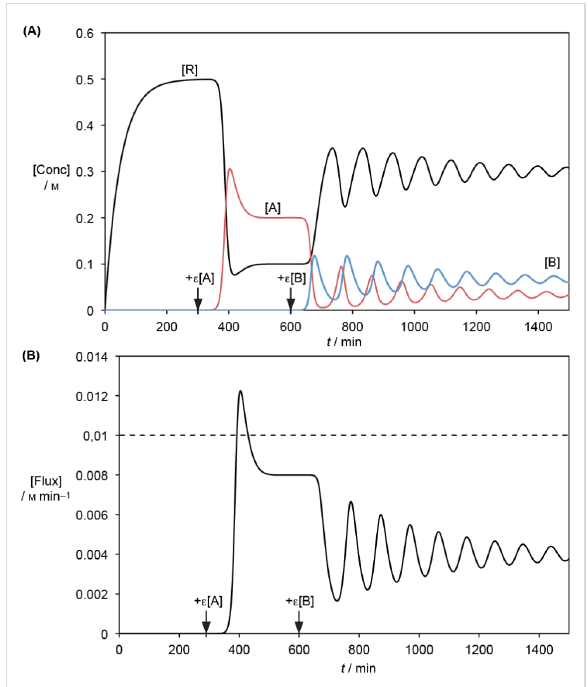
Figure 4: Numerical simulation of the system of Figure 3 ( k 0 = 0.01 M min − 1 , k 1 = 0.02 min − 1 , k 2 = 0.4 M − 1 min − 1 , k 3 = 0.04 min − 1 , k 4 = 1.2 M − 1 min − 1 and k 5 = 0.04 min − 1 ). (A) Evolu- tion of the concentrations of resource ( R ), autocatalyst ( A ) and predator ( B ) species; (B) flux of product formation through the autocat- alytic system from A and B . The initial